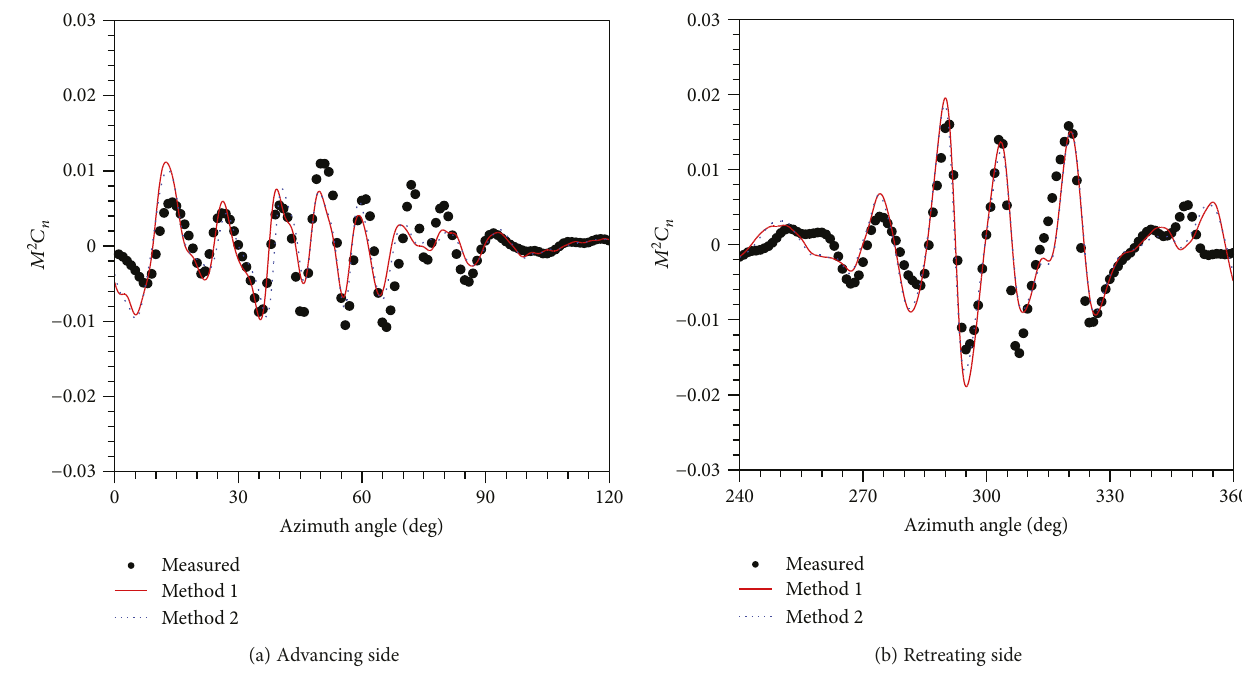
Figure 11: Comparison of higher harmonic contents (11/rev and higher) of section airloads M 2 C